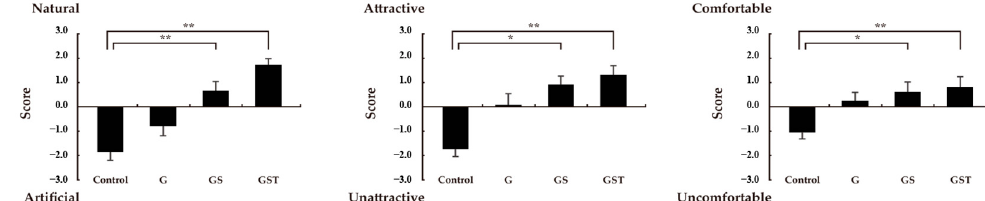
Figure 4. Differences in semantic differential scores among the four rooftop images in terms of feelings of naturalness, attractiveness, and comfort. Control: no vegetation with concrete floor; type G: grass vegetation; type GS: grass-shrubs vegetation; type GST: grass-shrubs-trees vegetation; n = 15, mean ± SE; *, p < 0.05; **, p < 0.01.